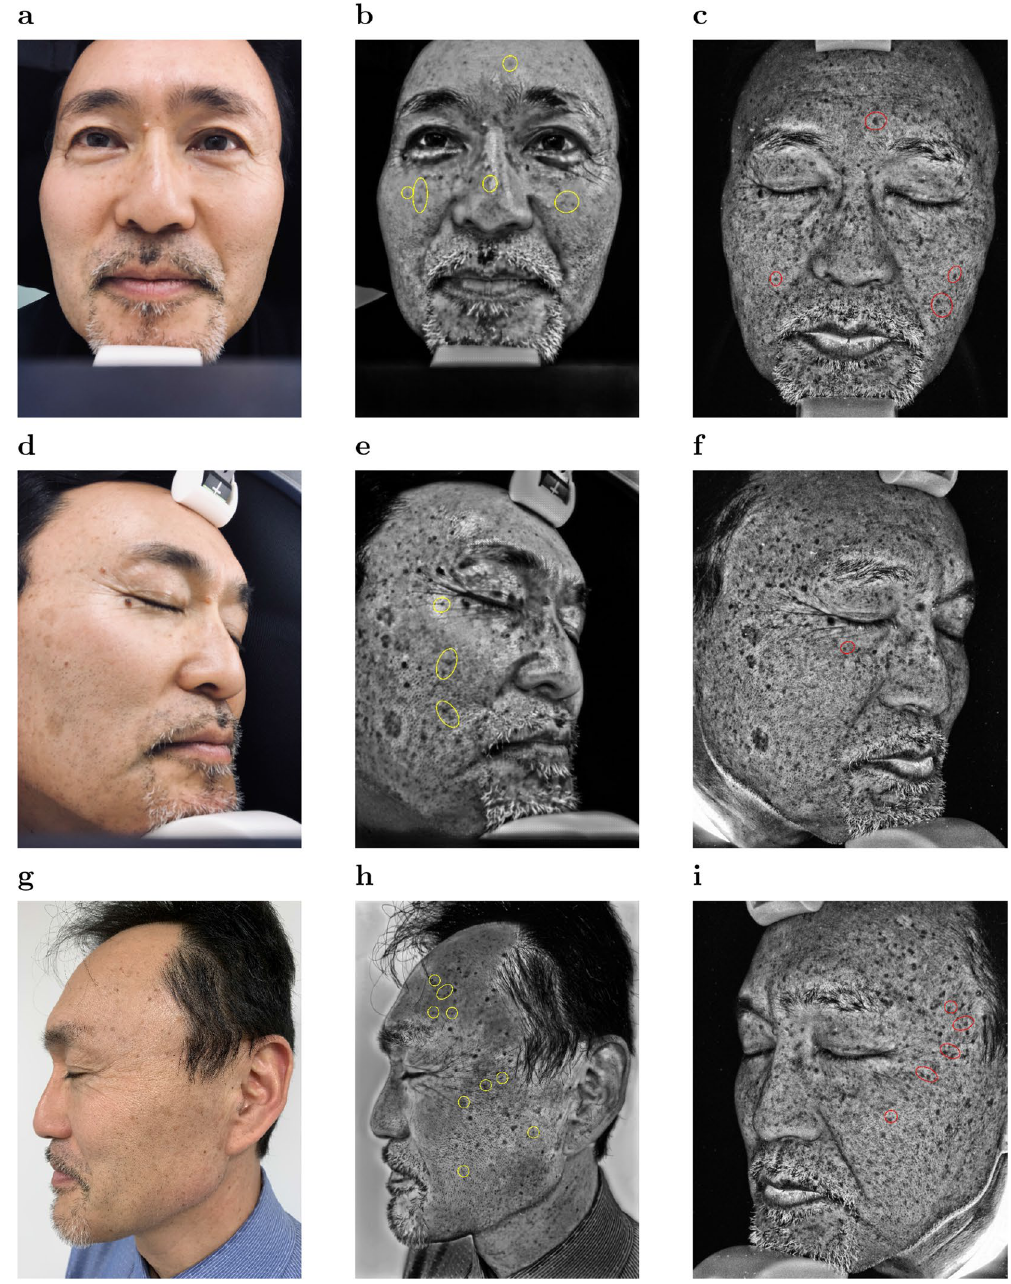
Figure 6. Color photo images for front, right profile, and left profile faces taken by iPhone ( a , d , g ), their respective synthetic UV images by UV-photo Net ( b , e , h ) from the iPhone photo images, and UV photo images for the front, right profile, and left profile faces taken by the VISIA system ( c , f , i